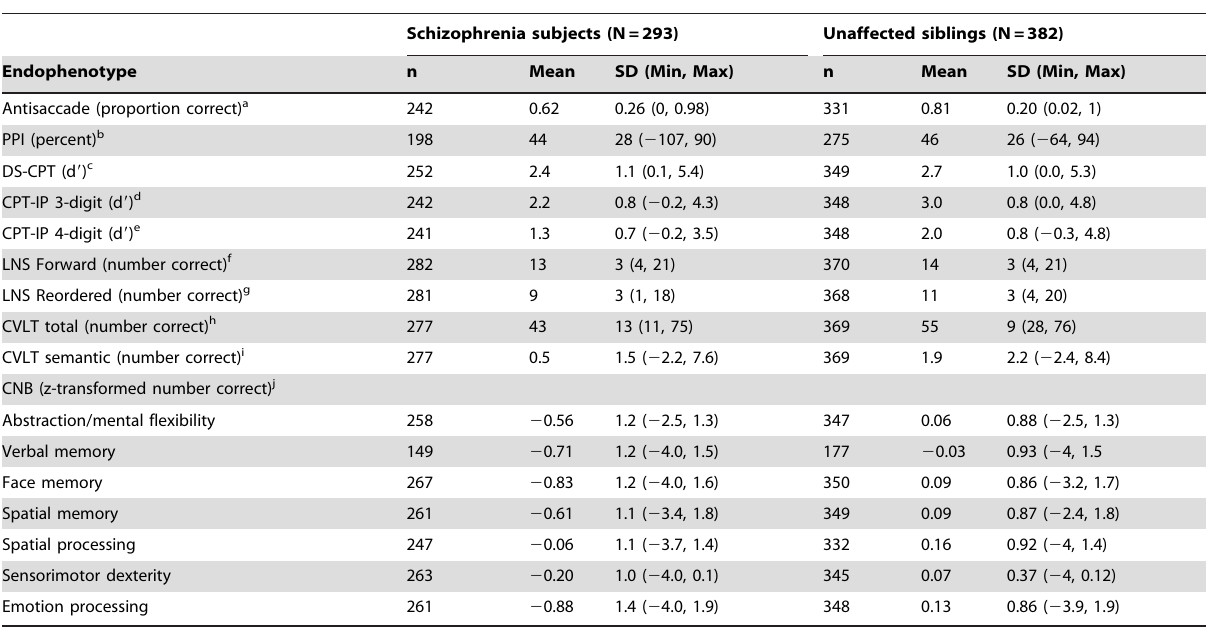
Table 2. Unadjusted endophenotypes for schizophrenia subjects and unaffected siblings.